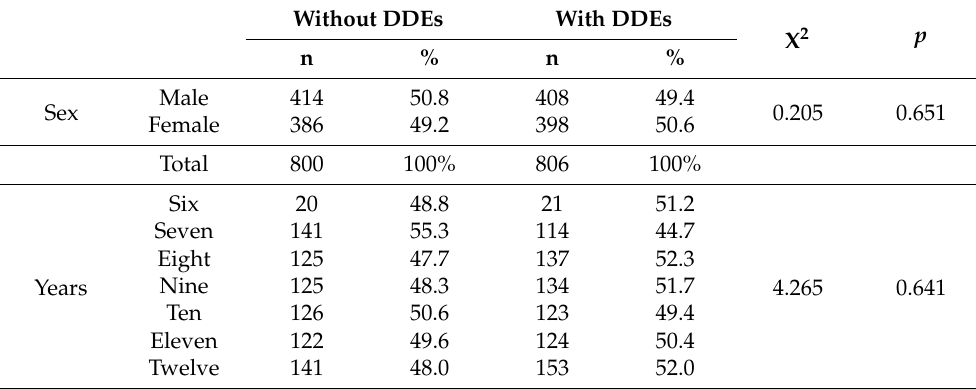
Table 1. Distribution according to sex and age.